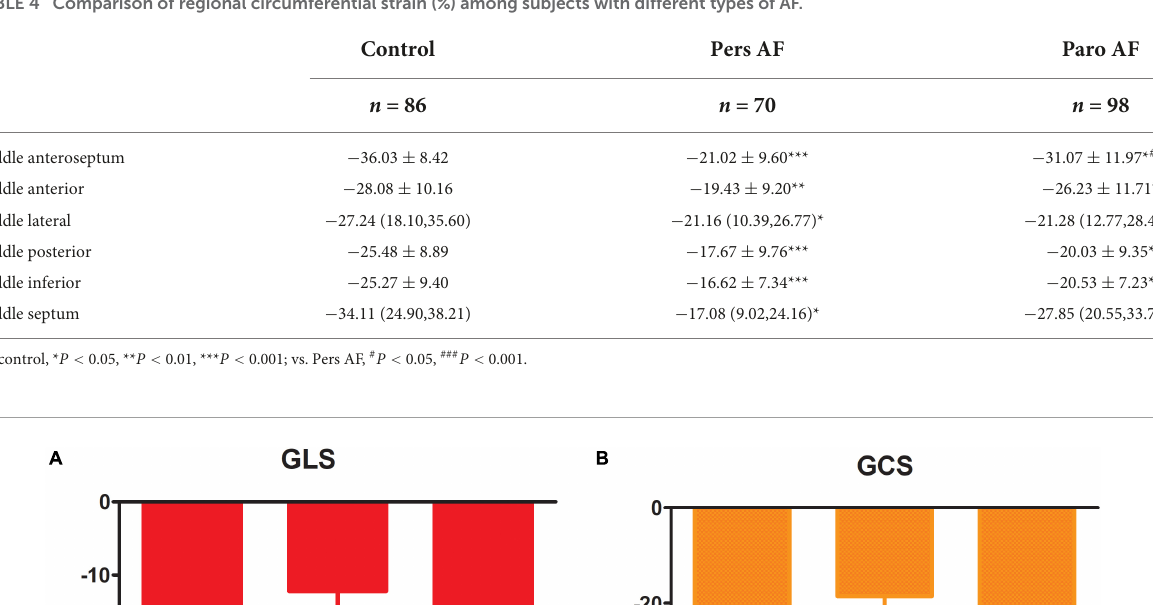
TABLE 4 Comparison of regional circumferential strain (%) among subjects with different types of AF.